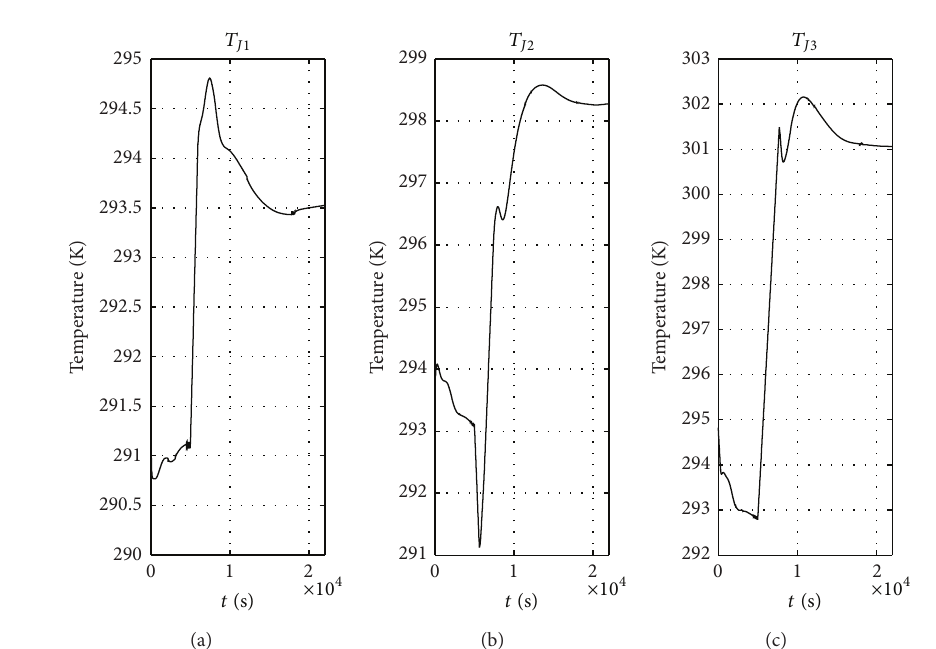
Figure 18: Control actions (jackets temperatures) of the MPC controller for Test